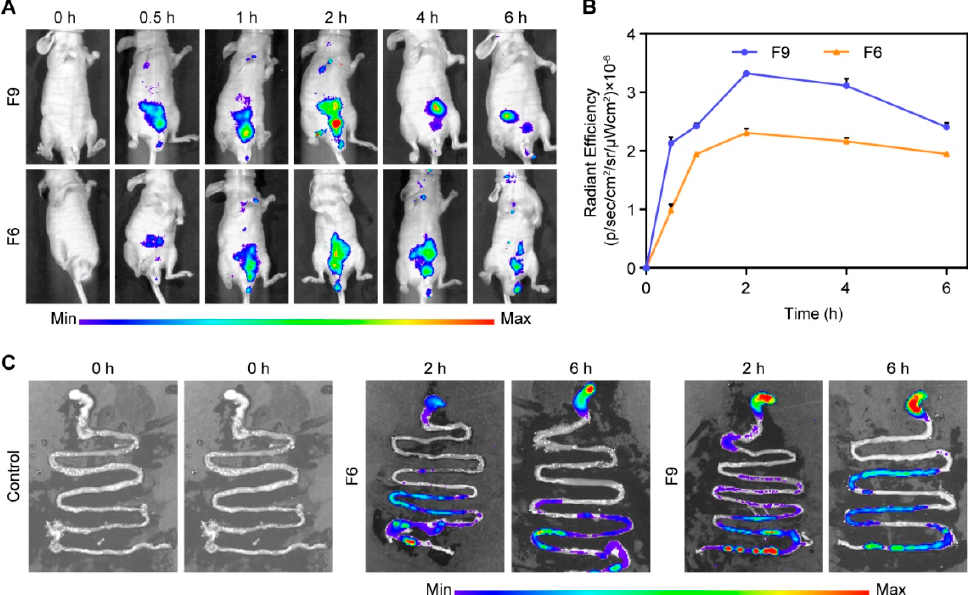
Figure 9. In vivo absorption of IMC–SDs. ( A ) Representative in vivo images of mice after gavage with IMC–SDs labeled IR820. Color scale: Minimum = 2.12 × 10 6 ; Maximum = 1.00 × 10 8 . ( B ) Quantitative fluorescent intensity of IMC–SDs (mean ± SD, n = 3). Average radiant e ffi ciency units: (p / s) / ( µ W / cm 2 ). ( C ) Representative in vivo images of the stomach and small intestine of mice after gavage with IMC–SDs labeled IR820. Color scale: Minimum = 2.12 × 10 6 ; Maximum = 1.00 × 10 8